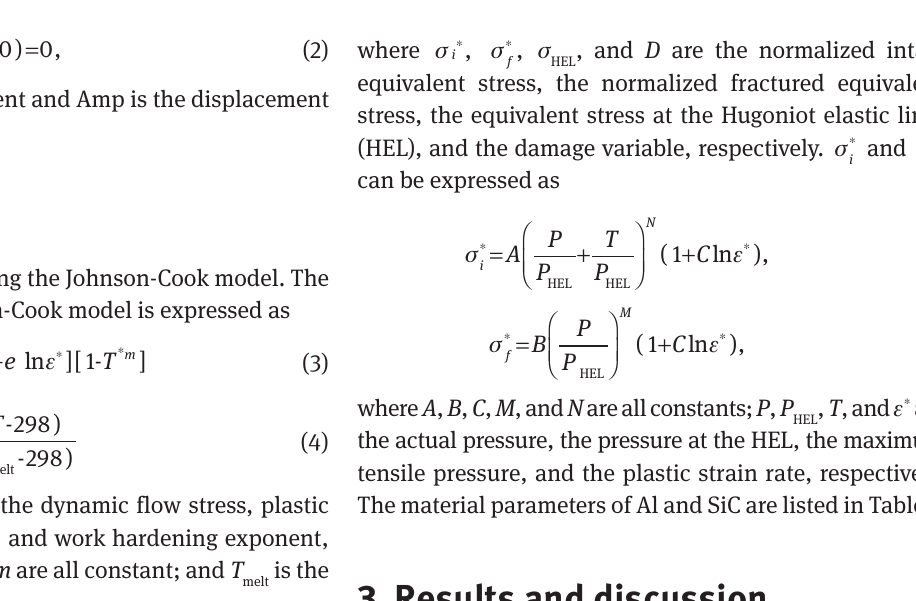
Figure 1 Stages of conversion of SEM image into FEM.